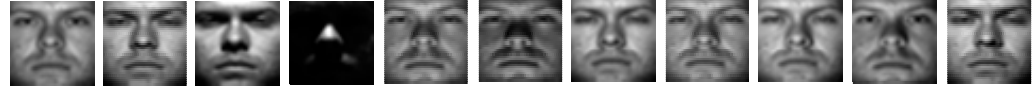
Figure 5. Some samples of one person with different light conditions on the Extended Yale database. Table 4. The best recognition rate and the corresponding dimension of each method on the Extended Yale B databases.